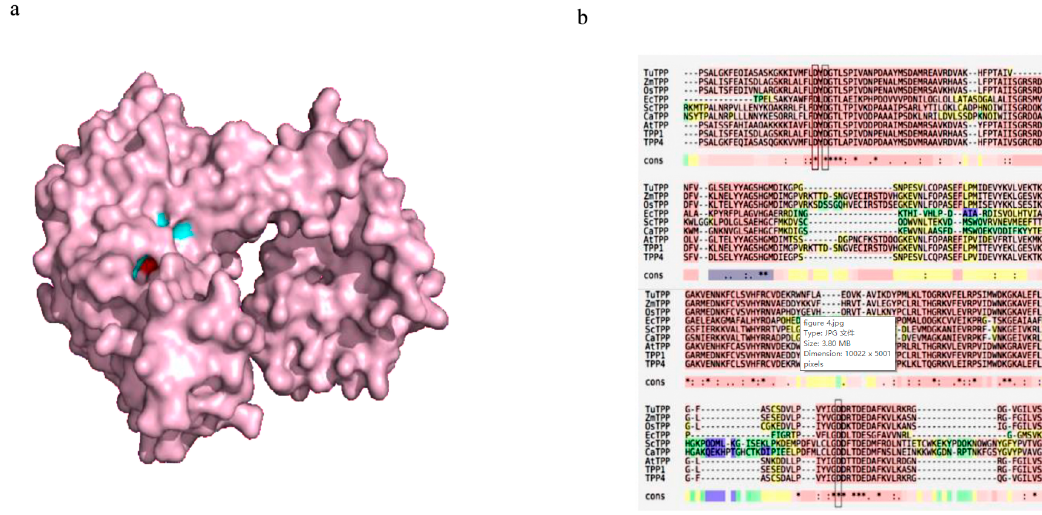
Figure 4. In silico analysis of TPP catalytic sites: ( a ) TPP-1 protein model with catalytic sites; ( b ) Alignments of the TPP domains from TPP-1 amino acid sequence and functional TPP proteins from different species.